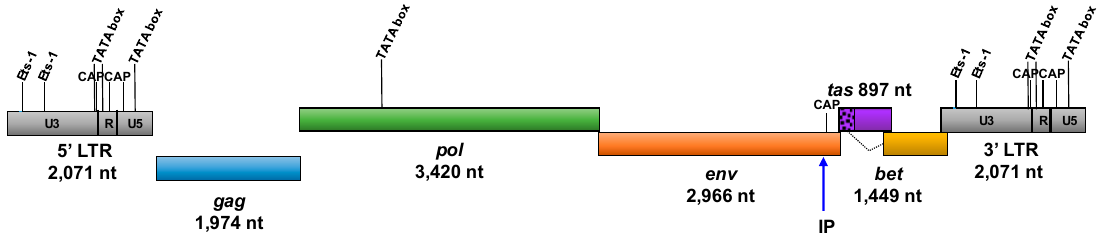
Figure 1. Genomic structure of SFVhpi_SAM106. Ets-1, ETS proto-oncogene 1 transcription factor motif; CAP, catabolite activator protein transcription motif; TATA box, promoter region motif; LTR, long terminal repeat; IP, internal promoter; gag , group-specific antigen; pol , polymerase; env , envelope; tas , transactivator gene; bet , between env and tas genes; U3, unique 3 ′ region of the LTR; R, repeat region of the LTR; U5, unique 5 ′ region of the LTR. The Bet protein is translated from a spliced RNA and residues from the 5 ′ part of tas indicated by the speckled region and dotted line.